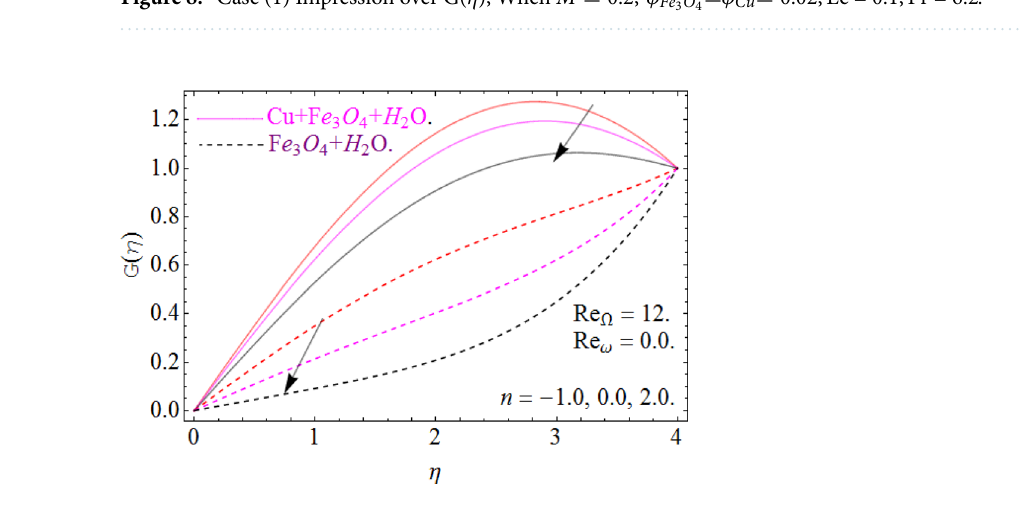
Figure 8. Case (1) Impression over G( η ), When M = 0.2, φ Fe 3 O 4 = φ Cu = 0.02, Ec = 0.1, Pr = 6.2 .